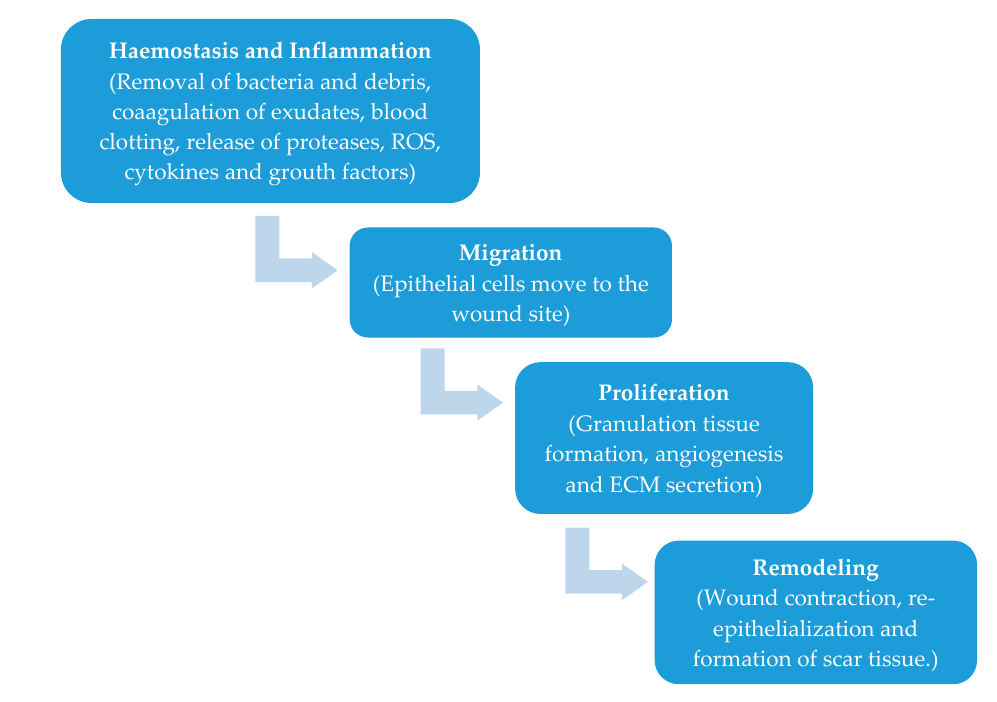
Figure 1. Phases of wound healing.